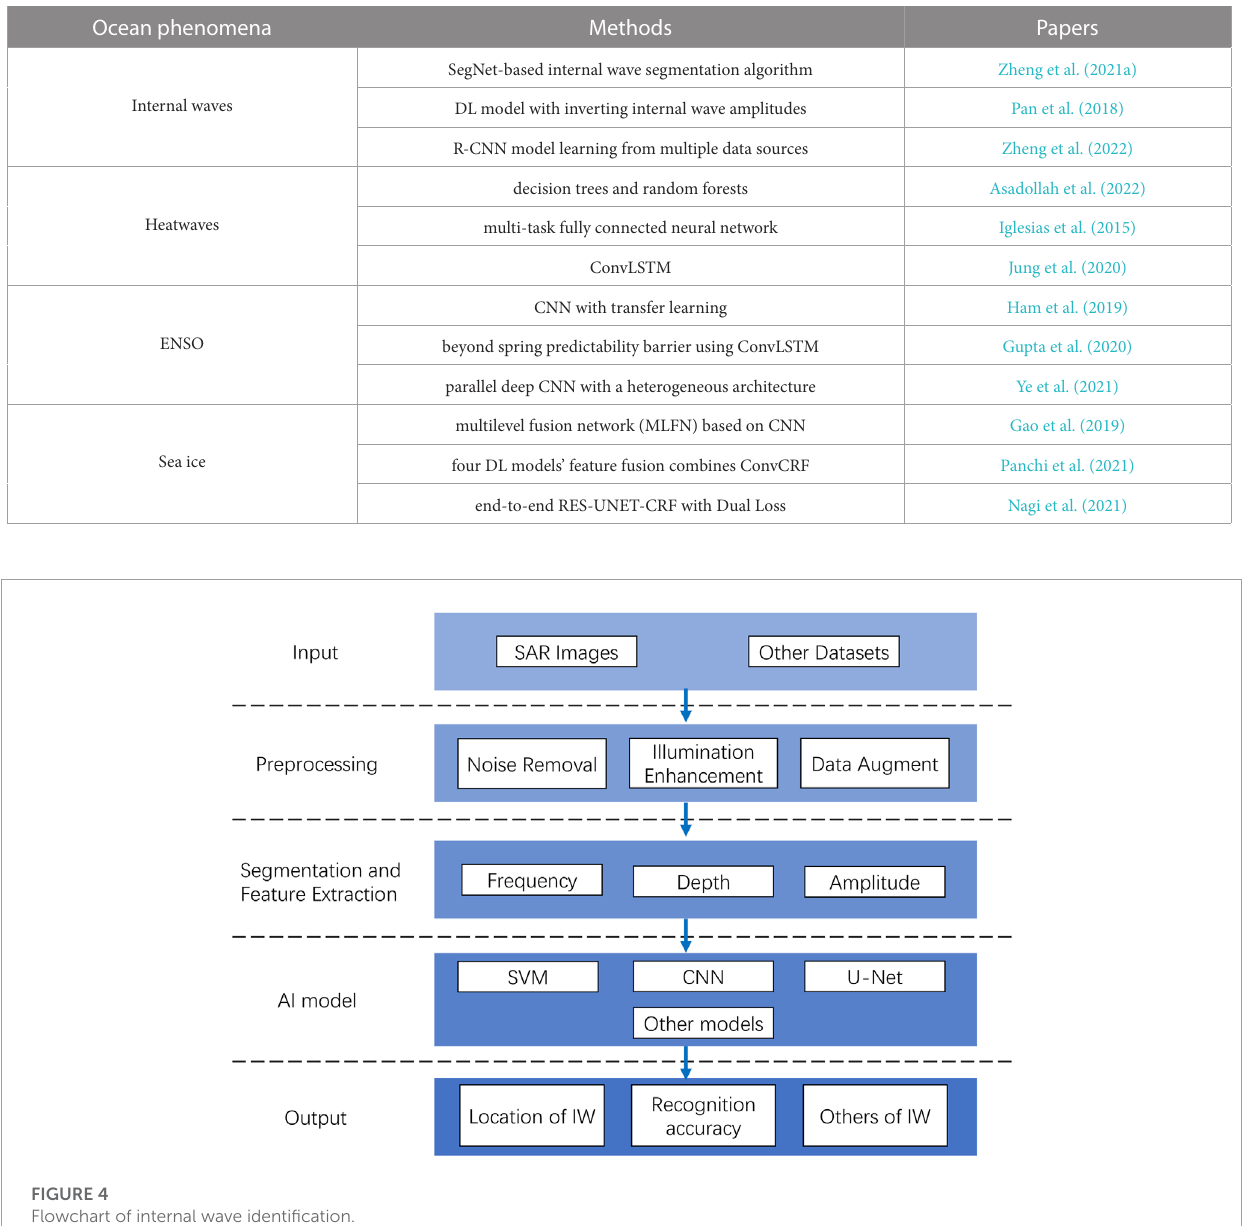
TABLE3 IdentificationofoceanphenomenawithAI.